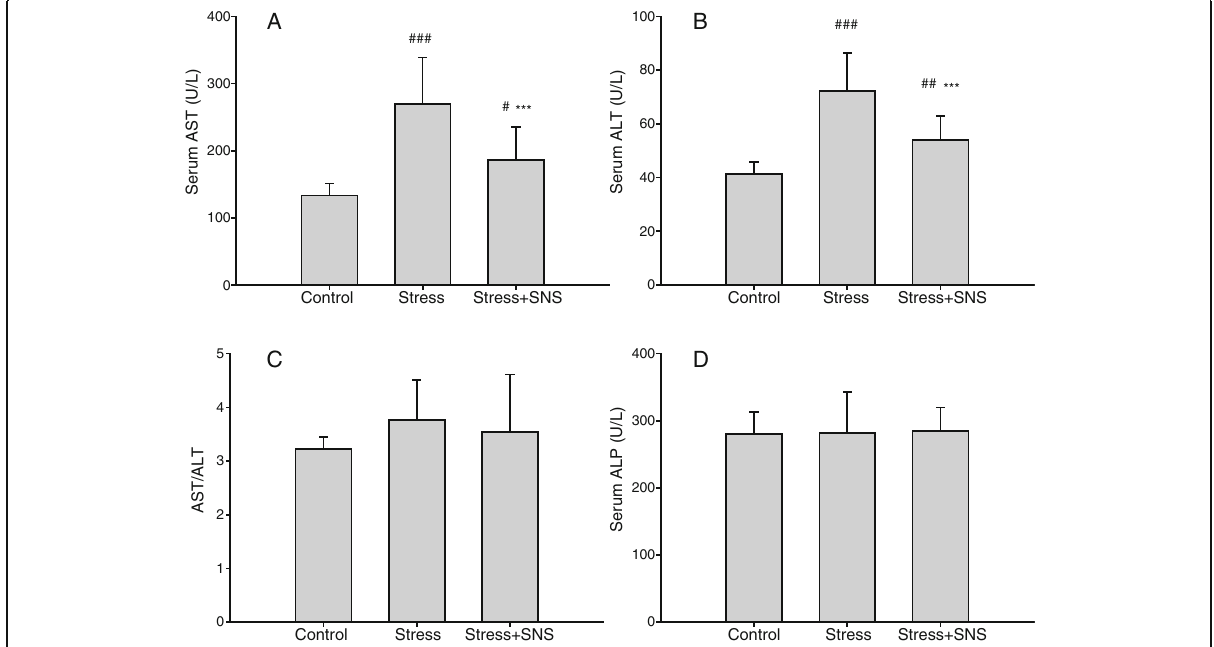
Fig. 4 The serum activities of three hepatic injury-associated enzymes, alanine aminotransferase, aspartate aminotransferase, and alkaline phosphatase. a The serum AST level. b The serum ALT level. c The AST and ALT ratio. d The serum ALP level. Values plotted are a mean ± standard deviation ( N = 10 per group). ### p < 0.001 versus the control group, *** p < 0.001 versus the stress group. SNS, Sinisan; ALT, alanine aminotransferase; AST, aspartate aminotransferase; ALP, alkaline